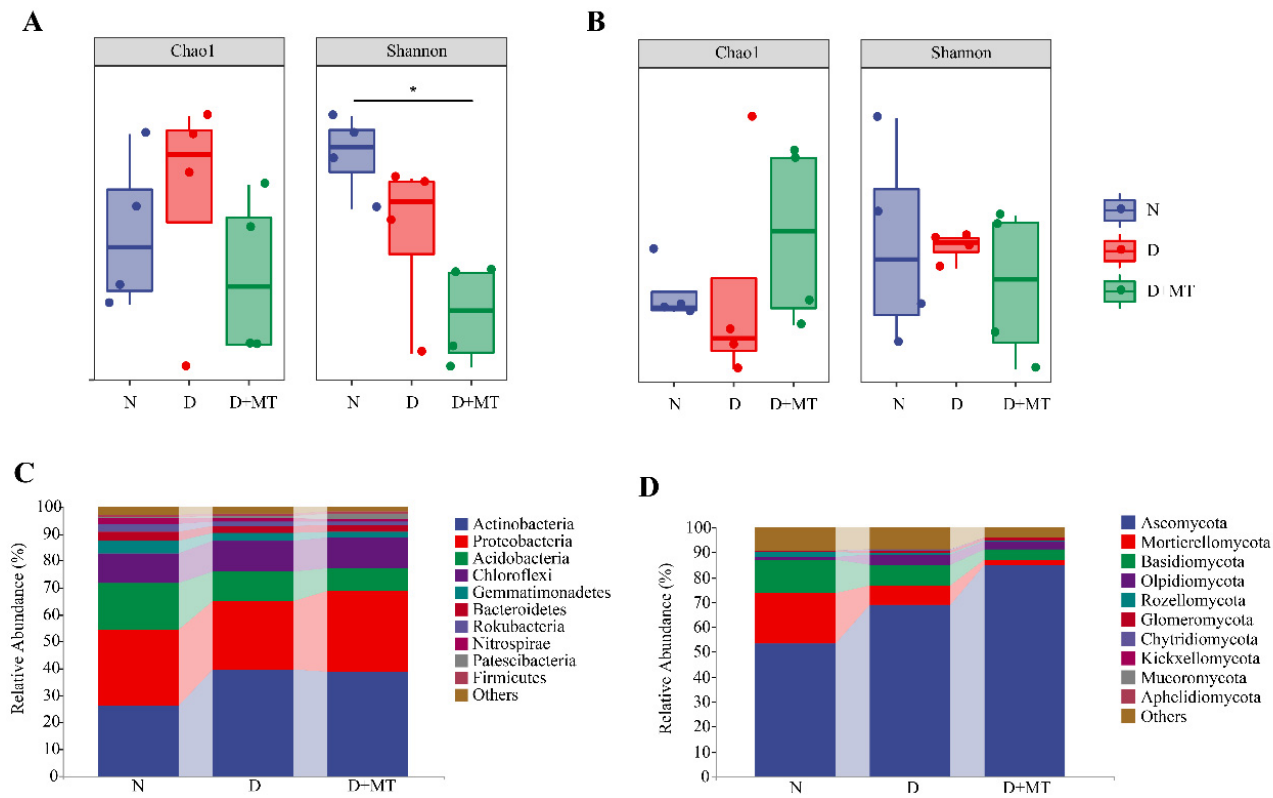
Figure 4. The α diversity and relative abundance in phylum level of bacteria ( A , C ) and fungi ( B , D ) as affected by melatonin treatment and drought stress. “*” indicates significance at p < 0.05. N, normal control; D, drought stress; D + MT, melatonin + drought stress.